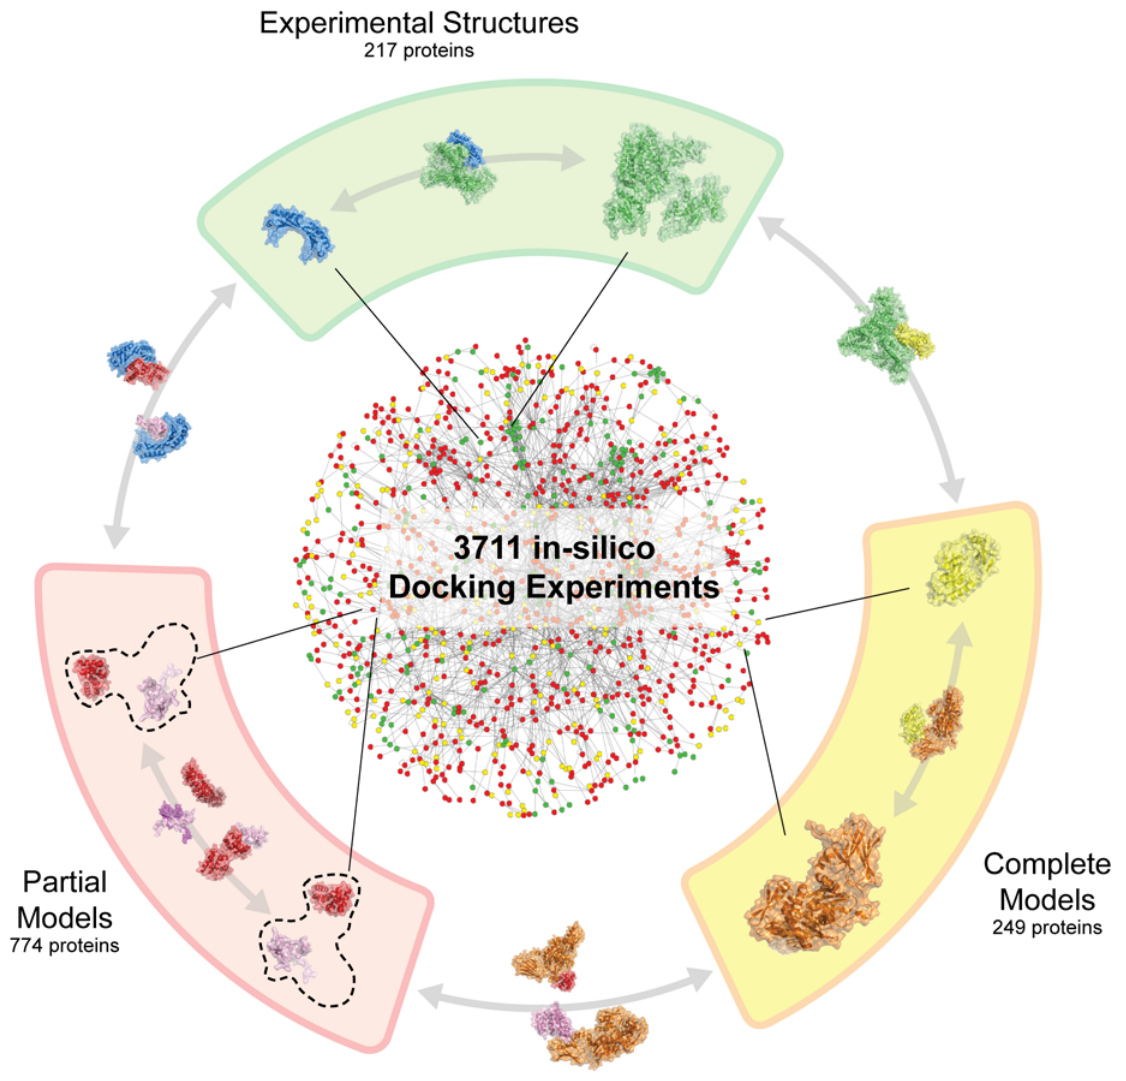
Figure 3. Overview of the high-throughput docking experiment on the yeast interactome. Experimental structures and homology models (complete and partial) were mapped on a high confidence subset of the yeast interactome. Docking experiments were performed for every pair of interacting proteins in order to predict the structure of the binary complex. Green points refer to proteins having experimental structures, yellow points to proteins having complete homology models and red points to the ones having only partial models. Every possible pair of structure types (experimental/experimental, experimental/model, model/model) was present in the experiment.